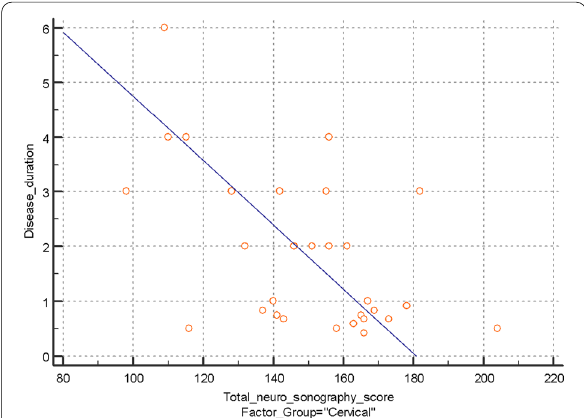
Fig. 6 Correlation between cervical group disease duration and total neuro‑sonography